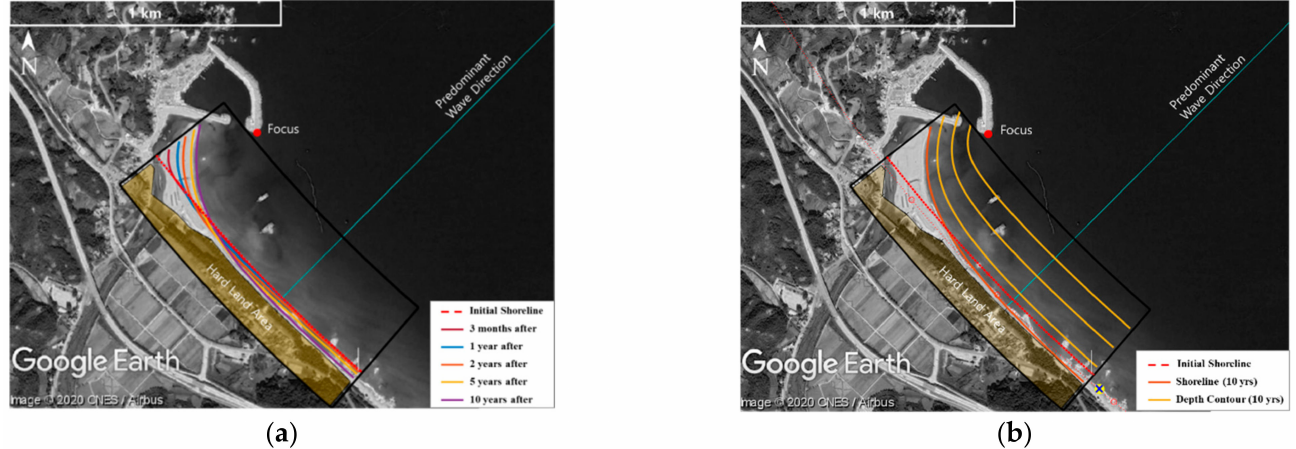
Figure 12. Shoreline change model simulation of change to Wonpyeong beach, caused by construction of Gungchon Port: ( a ) shoreline change; ( b ) depth contour change (image from Google Earth as at October 2012).